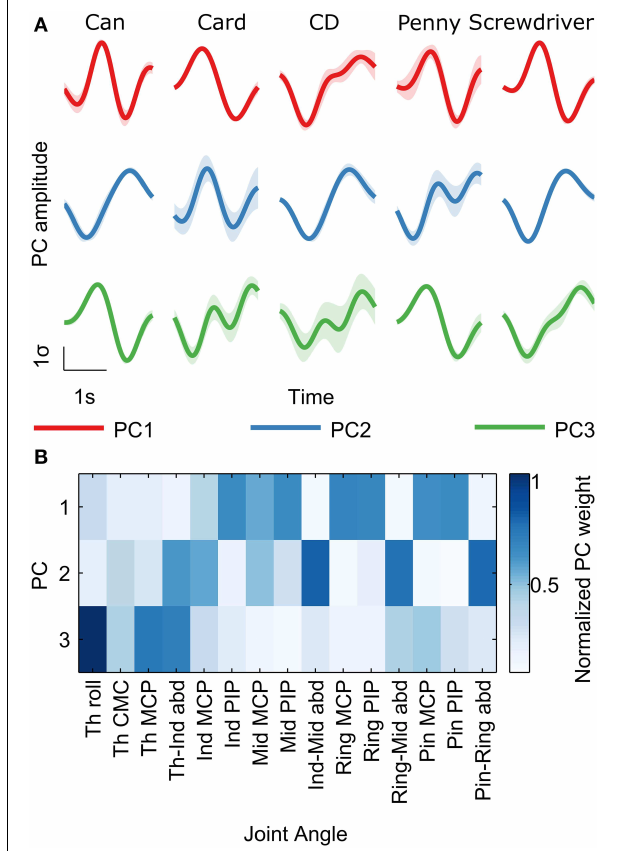
FIGURE 2 | Kinematic trajectories show synergies while grasping objects. Principal Component Analysis (PCA) was performed on the 15 recorded joint angular velocities across all trials for each subject. (A) Mean principal component (PC) amplitudes ( ± s.e.m; shaded regions) are shown for the first three PCs for all objects in subject S5, from 400ms before movement onset to 100ms after movement offset. For display purposes, the different trial lengths for an object were rescaled in time to the mean trial length for that object. PC amplitudes from each trial were standardized to zero mean and unity standard deviation. (B) PC loading (weights) on the 15 joint angles are shown for the first three PCs. Darker colors represent larger weight magnitudes averaged across all subjects, normalized between zero and one. PC1 is highly loaded on the finger PIP and MCP joints representing grasp opening/closing motion. PC2 is loaded mainly on the abduction joints, representing the spreading motion of the hand. PC3 is loaded on the thumb joints, mainly rotation, and represents the independent movement of the